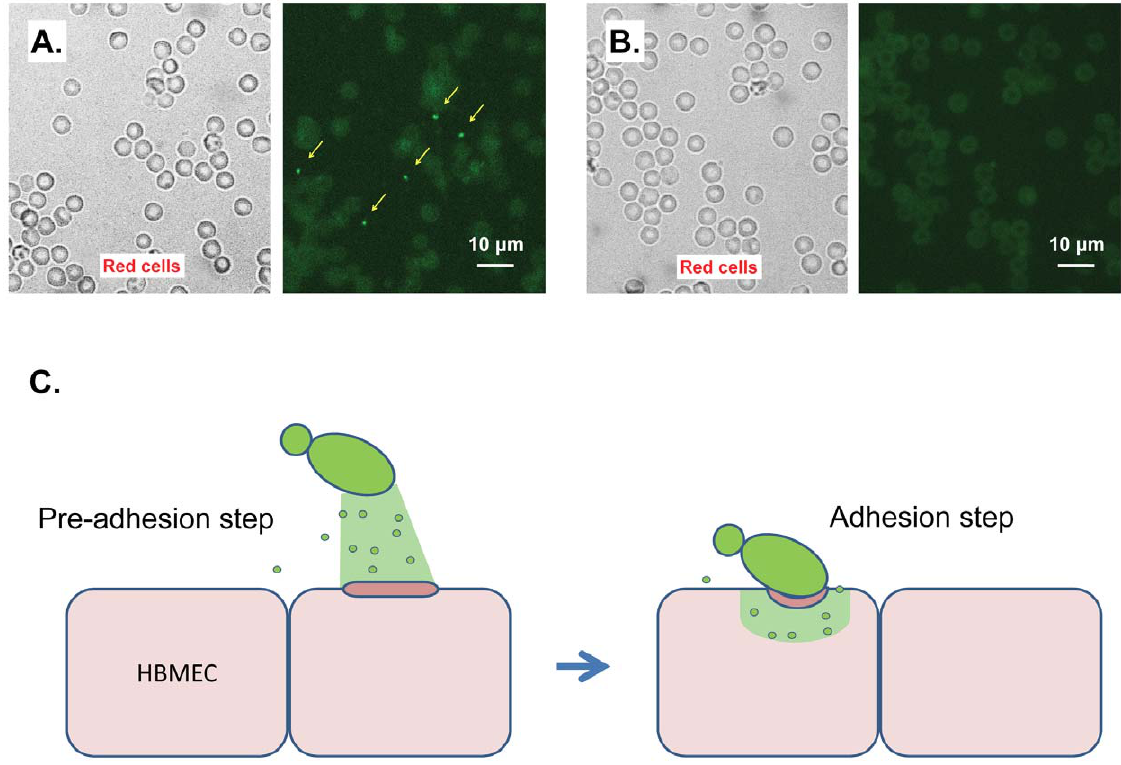
Figure 8. Detection of CnMV particles in infected mouse blood. Mice were intravenously injected with 5 6 10 6 cryptococcal cells of either strain JBO2 ( A ) or strain C1186 ( B ). After 16 hr, a drop of blood was collected from either the eyes or the tail vein, and was plated onto the glass slide. Red blood cells were observed under the light microscope (left panel) and green CnMV particles (indicated by yellow arrows) could be observed in the immunofluorescence image of JBO2 sample (A: right panel). ( C ) A model of the putative role of disseminated CnMVs to facilitate C. neoformans traversal through the blood-brain barrier is shown. The middle section shows the monolayer of human brain microvascular endothelial cells (HBMEC) (light pink cells). C. neoformans cells (green) may continuously secret extracellular vesicles CnMVs into the blood stream. Intact CnMVs (green dots) and/or already-lysed components of the CnMV’s ( e.g ., green sector area) contact the HBMEC and exert some profound effects on the surface of HBMEC (dark pink bar), a pre-adhesion step. Subsequently, the active surface is facilitated for C. neoformans binding with the HBMEC, the adhesions step.